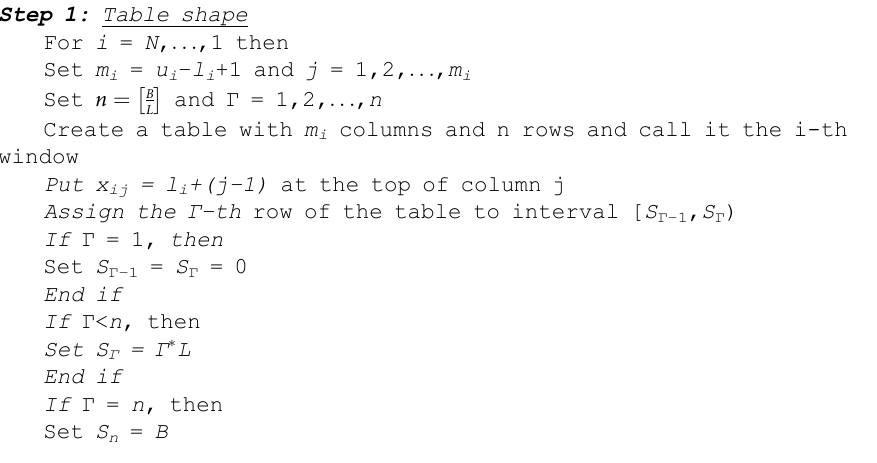
Algorithm 1: Pseudocode of dynamic programming